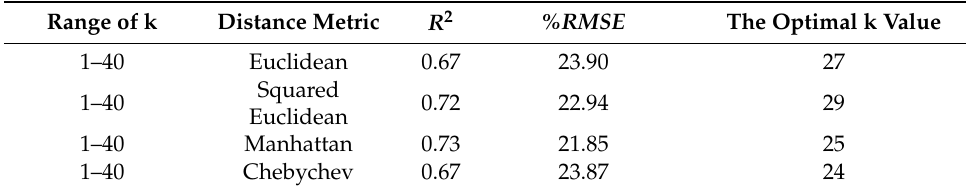
Table 4. Performance of aboveground biomass estimates using the kNN algorithm. Range of k